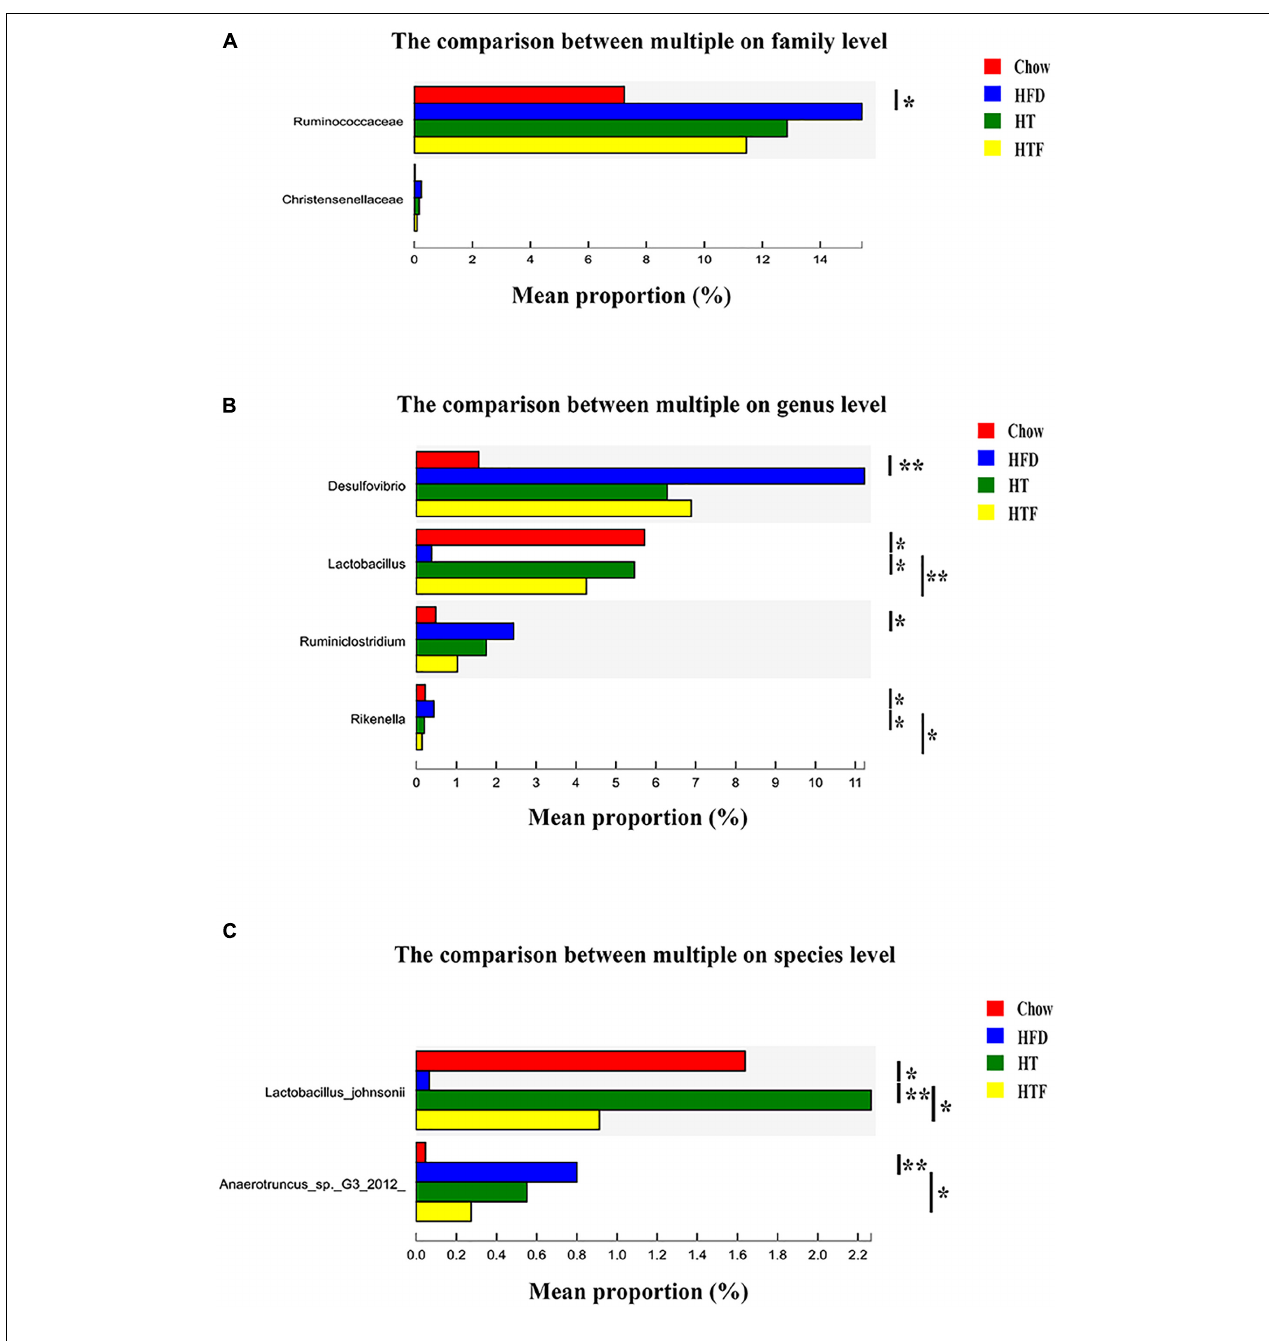
FIGURE 5 | The analysis of species difference in different groups. The comparison between HFD and the other three groups in family (A) , genus (B) and species (C) level based on wilcoxon rank sum test ( ∗ P ≤ 0.05; ∗∗ P ≤ 0.01).